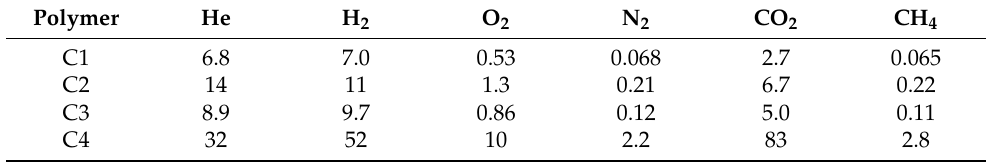
Table 3. Experimental gas permeability coefficients P (Barrer 1 ) for synthesized polymers at (21 ± 2 ◦